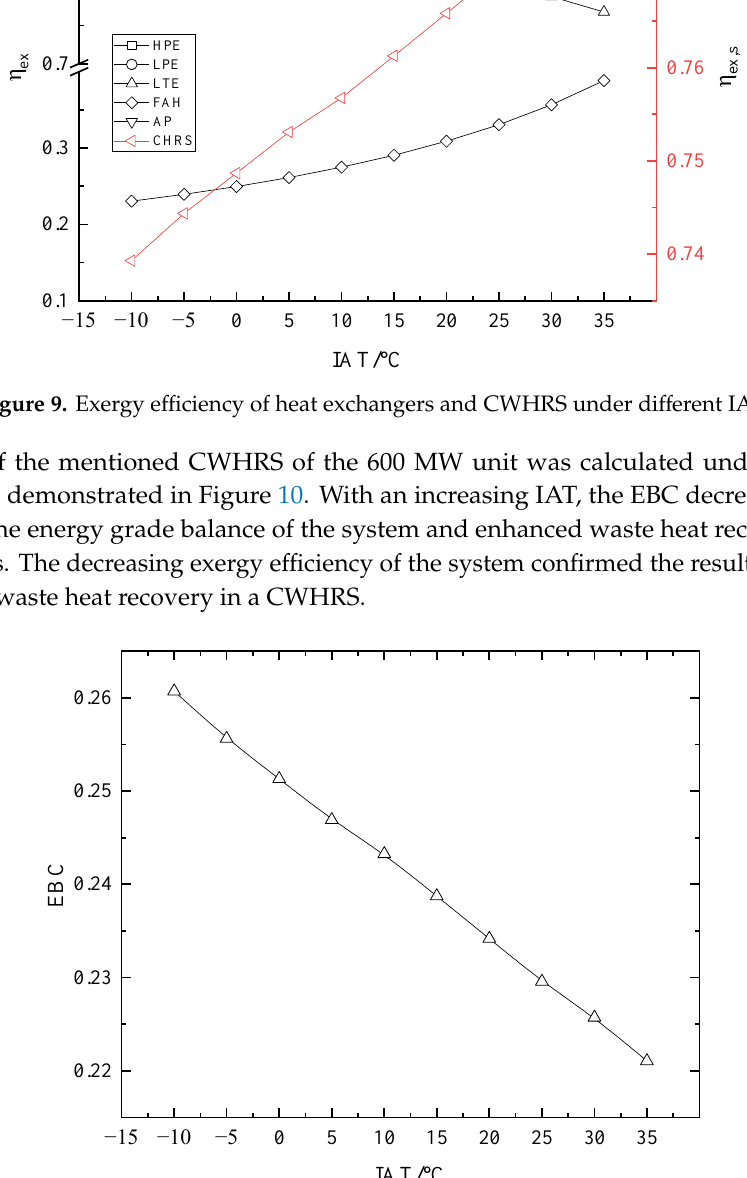
IAT/°C Figure 11. ONT at different IAT. 6. Conclusions Based on the theory of heat balance, exergy balance and energy grade balance, a CWHRS was analyzed, and the IFT of LTE was defined as the node temperature of the system. Taking a CWHRS installed on a 600 MW unit as an example, the exergy efficiency of heat exchangers and the system